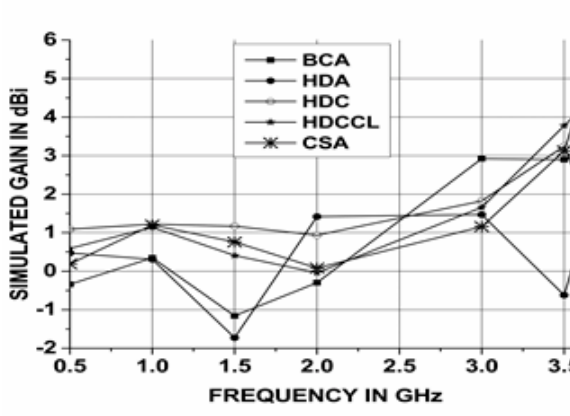
Figure 3: Simulated Gain of antennas at